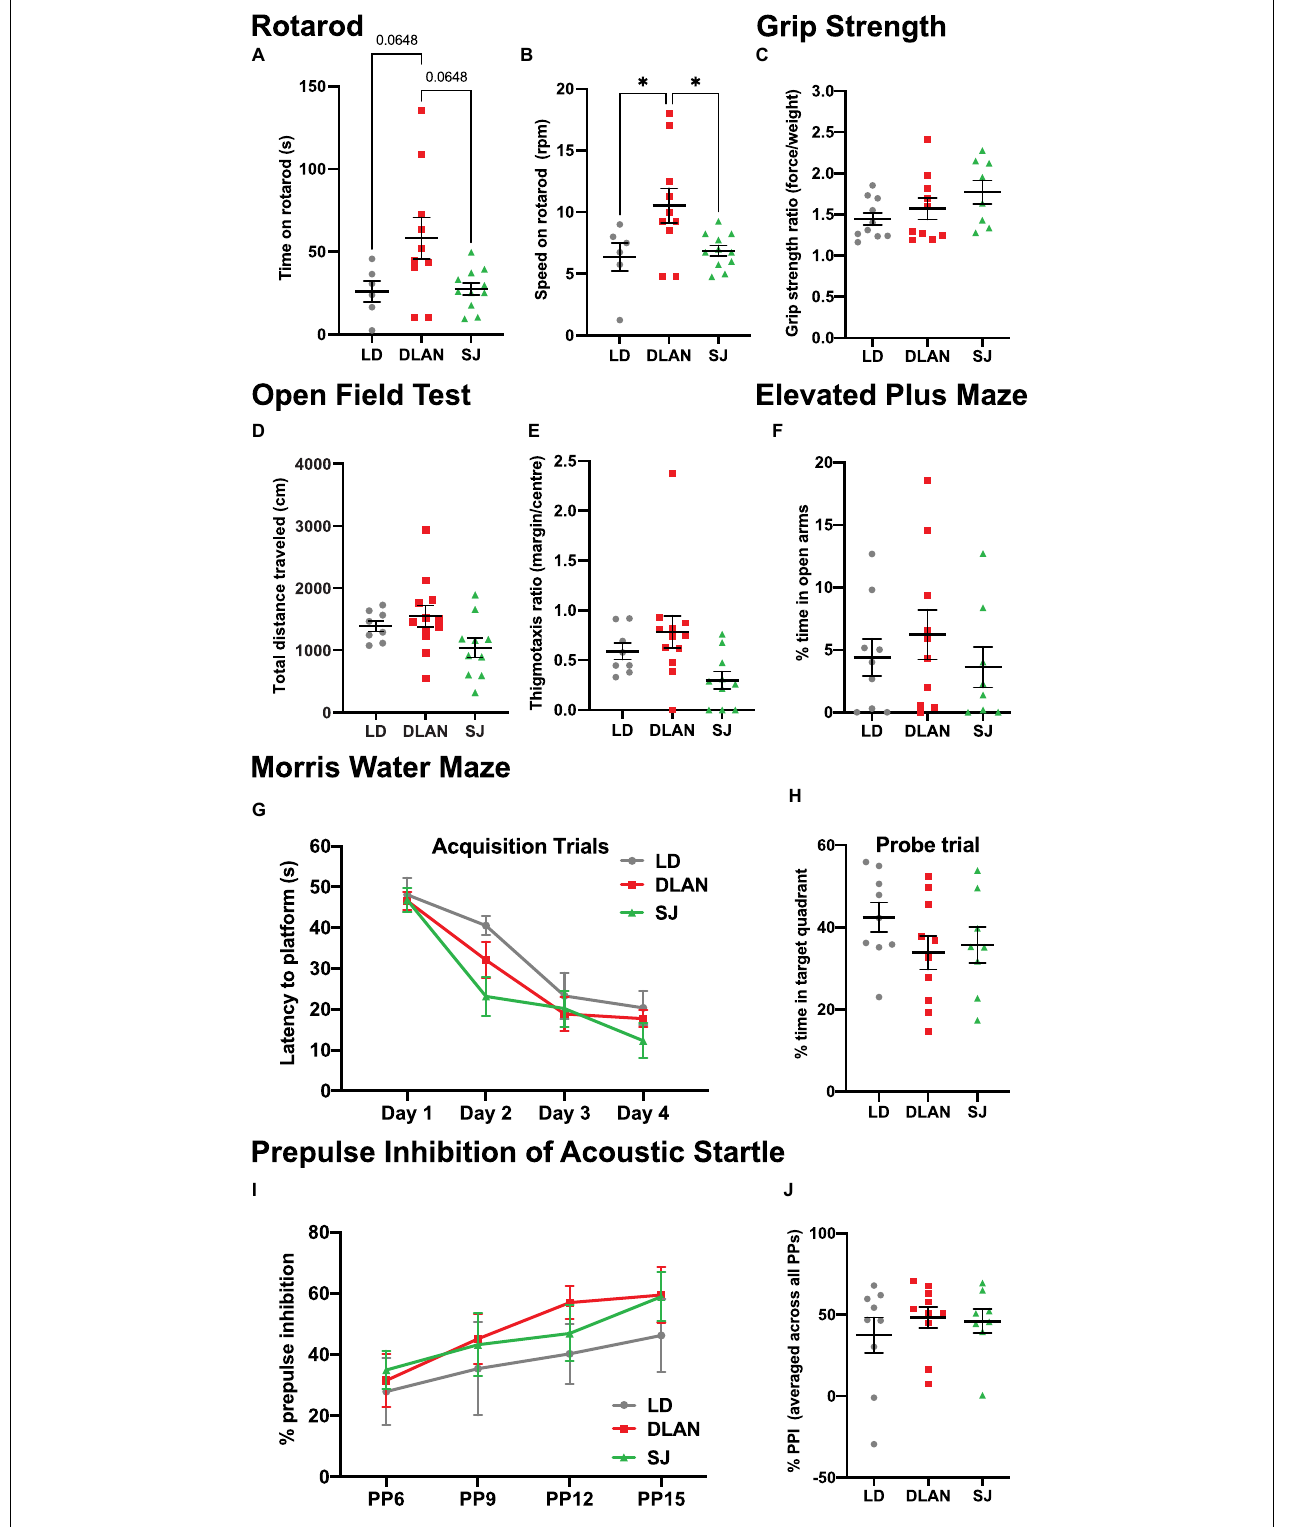
FIGURE 6 | Chronic exposure to abnormal lighting conditions affects some measures of motor function, but not exploratory behavior, anxiety-like behavior, spatial learning and memory, and sensory motor gating. (A–C) Motor function was tested on the rotarod, where time on rotarod (A) and speed on rotarod (B) were